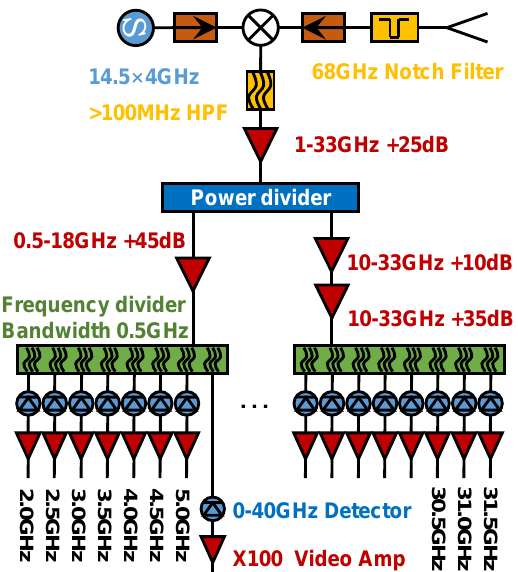
Figure 1. Schematic of the newly developed 60-channel ECE